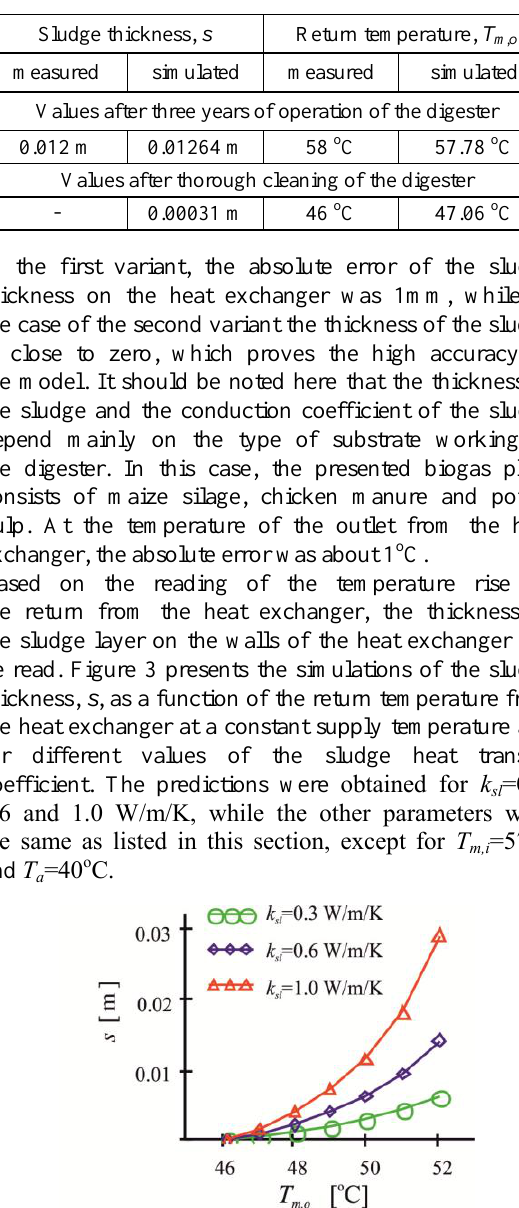
Table 1. Simulated and measured values of sludge thickness on the walls of the heat exchanger tubing and the temperature of return from the heat exchanger.